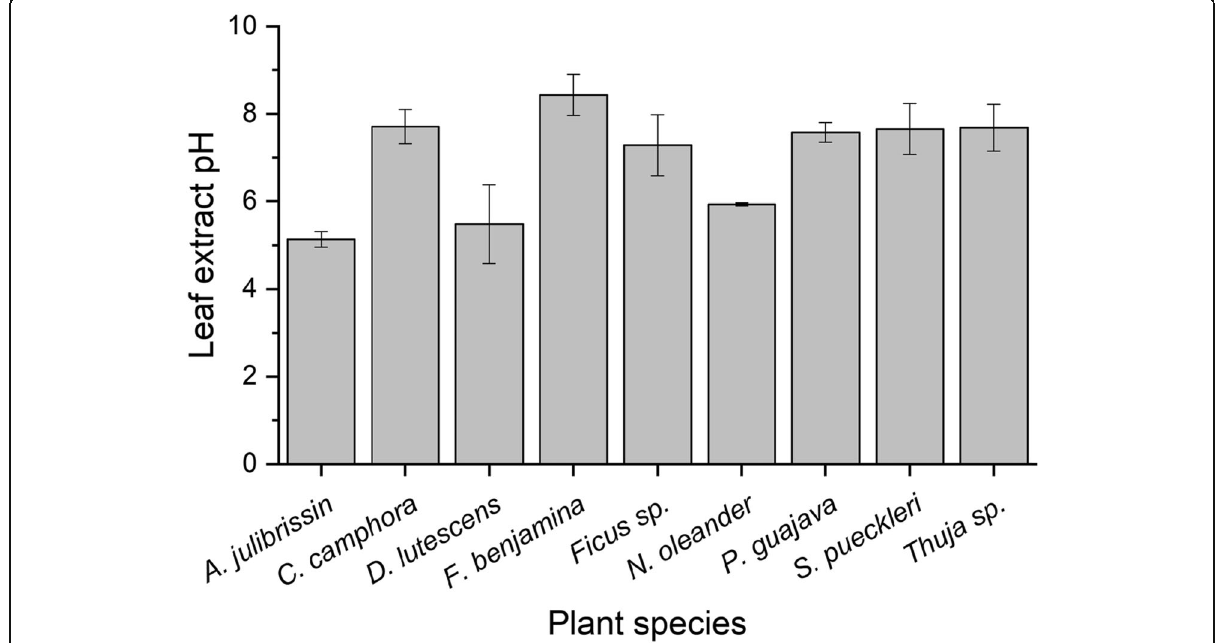
Fig. 4 Average leaf extract pH of the selected plant species; error bars represent the standard deviation ( n = 6)